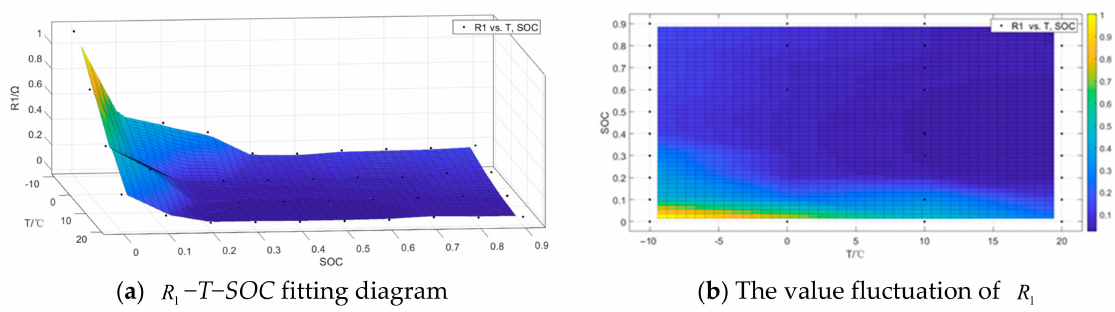
Figure 10. Variation of R 1 with temperature and SOC at low temperature ( T ≤ 20 ◦ C).